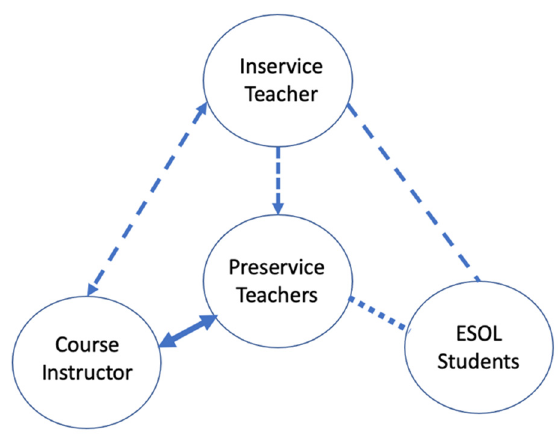
Figure 4. Development stage.